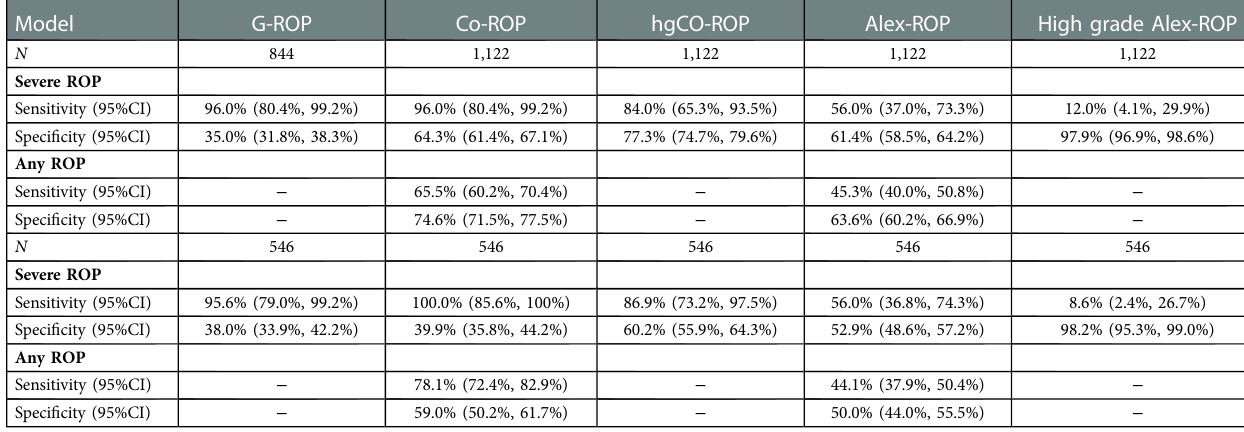
TABLE 2 Prediction of severe ROP and any ROP using G-ROP, CO-ROP and Alex-ROP. Model